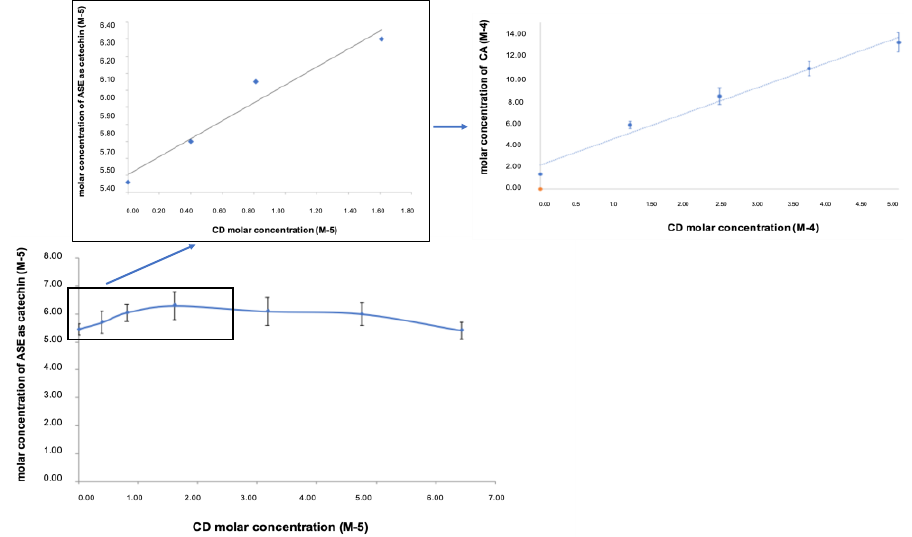
Figure 1. Solubility phase diagram of acetonic almond skins extract (ASE) in the presence of β-cyclodextrin (CD), compared to that of catechin (CA).